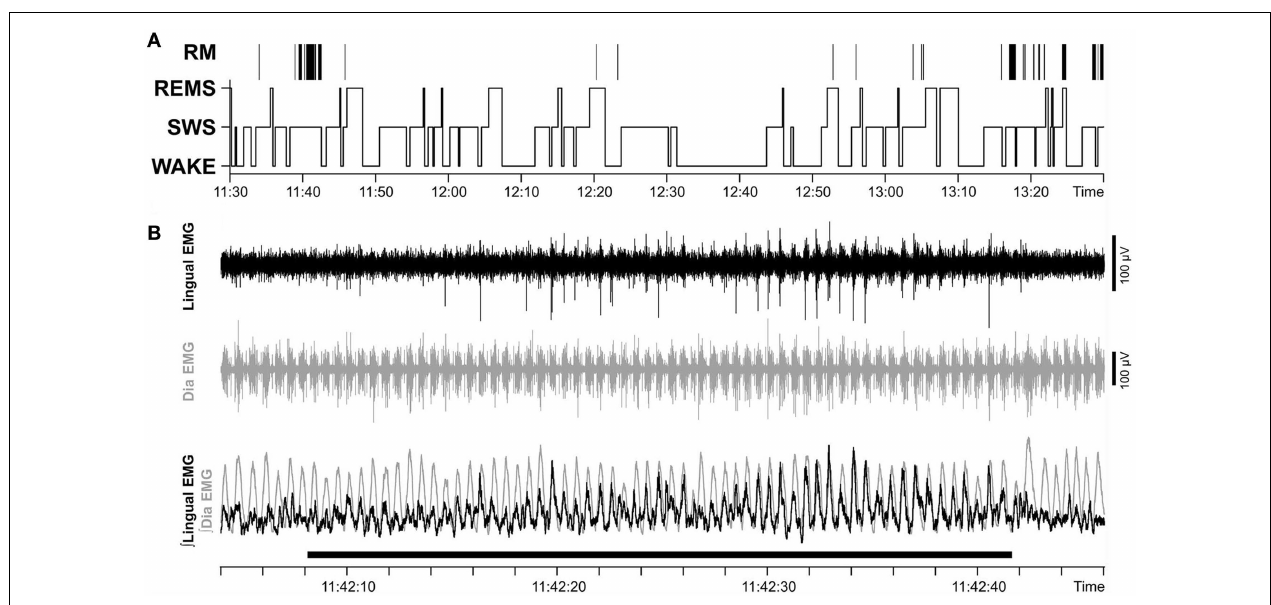
session. (B) Example of a record from the session illustrated in (A) during which inspiratory modulation appeared and then faded away during a period of SWS.The record is 44s-long and shows the raw and integrated lingual and diaphragmatic (Dia) EMGs. Superposition of the integrated EMGs from both muscles (bottom trace) reveals that lingual EMG is inspiratory-modulated with a stable phase relationship relative to diaphragmatic activity during the 32s-long period marked by the horizontal bar at the bottom.